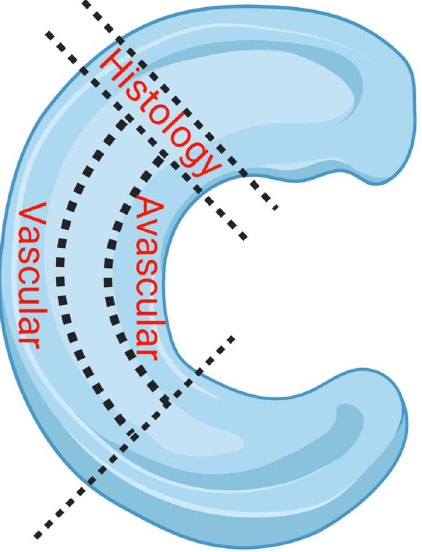
Figure 8. Schematic diagram of the process used for meniscus dissection: The medial body of the macroscopically “normal” meniscus was longitudinally divided into three parts: the inner third was used to extract avascular meniscal cells, the outer third for the extraction of vascular meniscal cells. The adjacent section which composed of the inner and outer regions was dissected for histological grading. Figure was created with